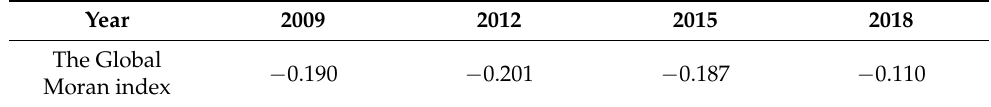
Table 5. The global Moran’s I index from 2009 to